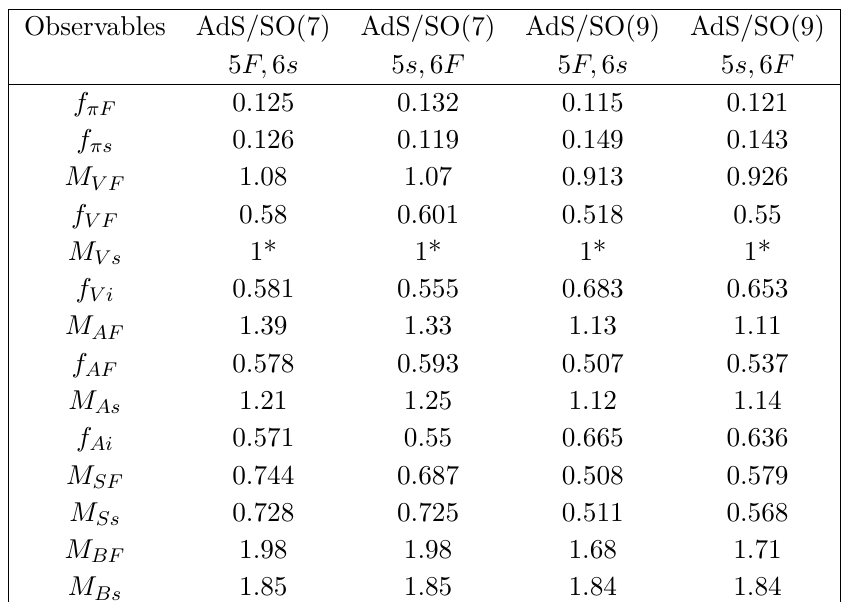
Table 8. Holographic results for the masses and decay constants in the two SO(7) and the two SO(9) theories with two matter representations that can trigger chiral symmetry